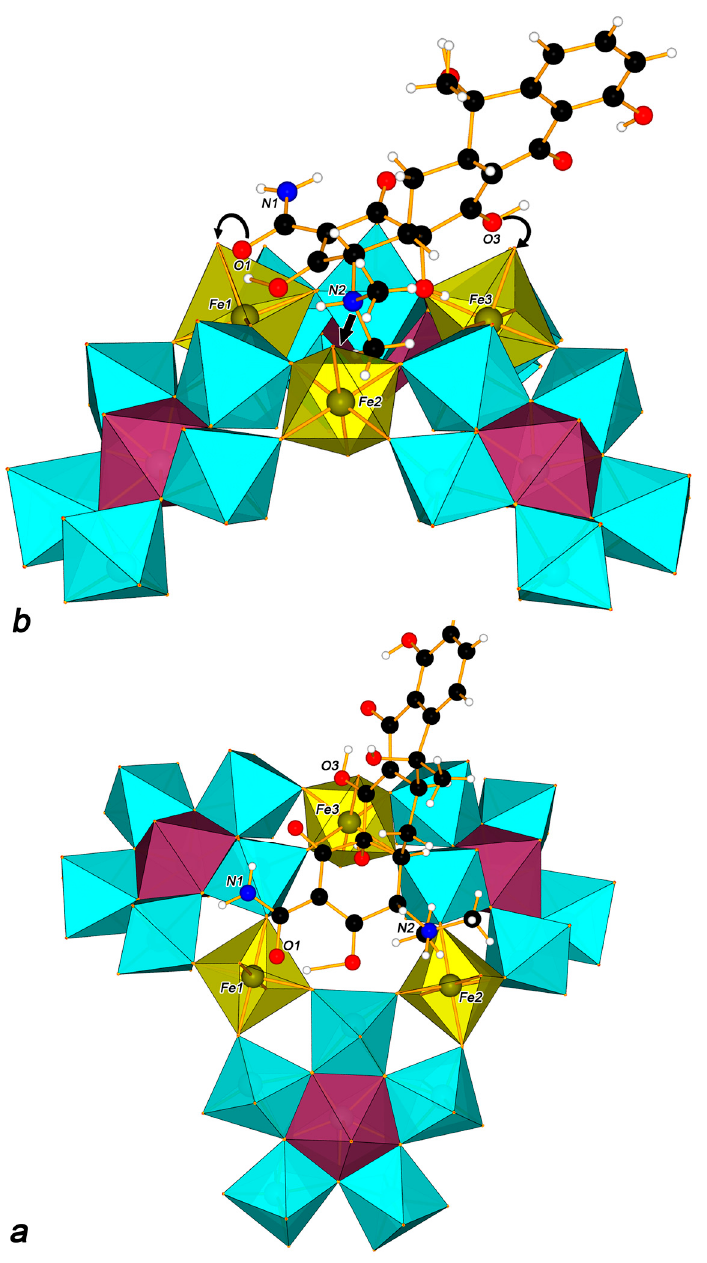
Figure 4. A 3D model of TC molecule binding to the {Mo 2 Fe 3 O 6 } pore in the {Mo 72 Fe 30 } structure from various angles ( a , b ). Polyhedra code: yellow—FeO 6 ; light blue—MoO 6 ; purple—MoO 7 . Atomic code: black—carbon; blue—nitrogen; red—oxygen.